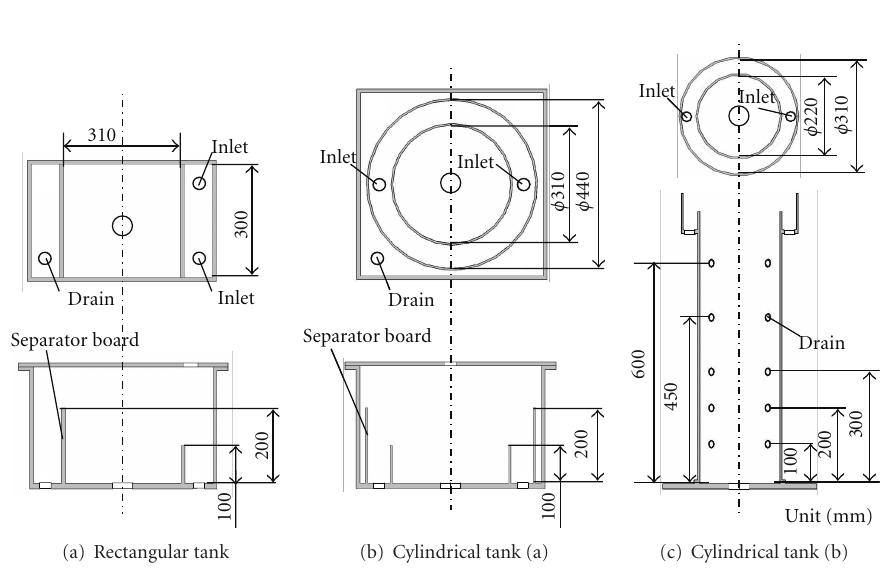
Figure 1: Experimental setup.